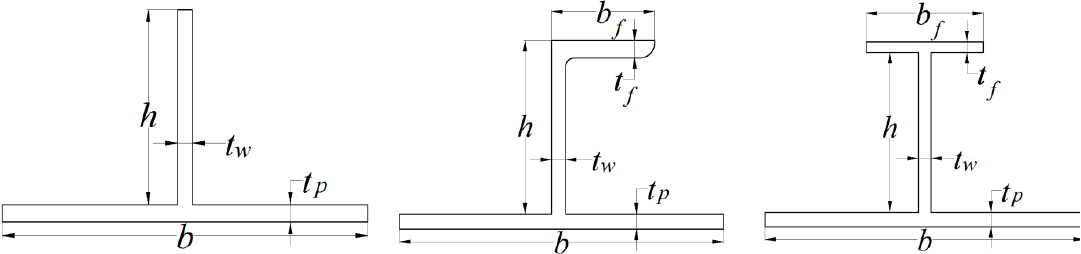
Figure 1. Definition of cross-sectional dimension of stiffened plate. Table 1. Dimensions of stiffeners.